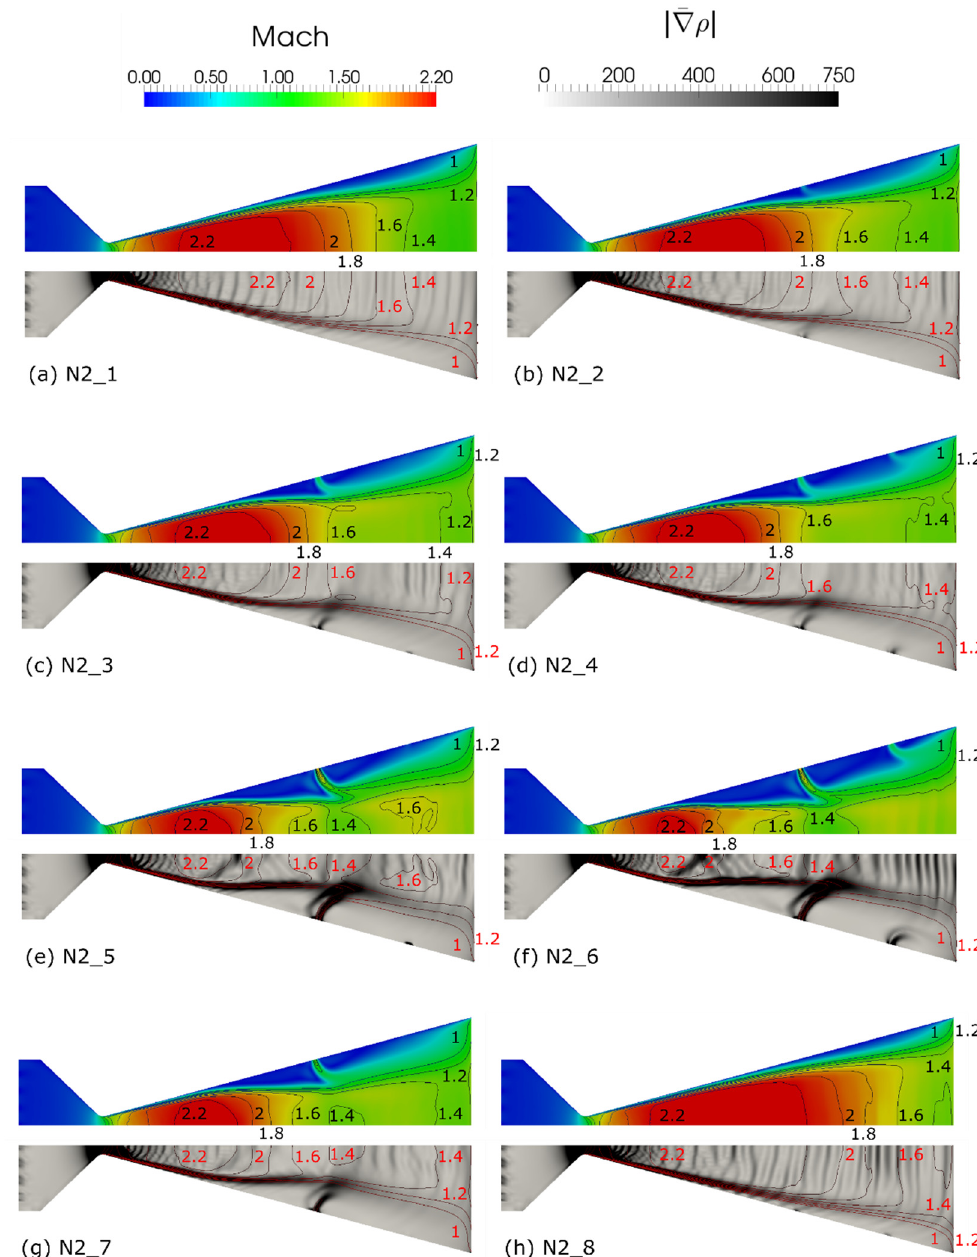
Figure 9. Contour plot of the Mach number and Schlieren computations: ( a ) test case N2_1 (baseline); ( b ) test case N2_2 (additional mass flow rate, jet 1 = ON, jet 2 = OFF); ( c ) test case N2_3 (additional mass flow rate, jet 1 = ON, jet 2 = OFF); ( d ) test case N2_4 (additional mass flow rate, jet 1 = ON, jet 2 = ON); ( e ) test case N2_5 (additional mass flow rate, jet 1 = ON, jet 2 = OFF); ( f ) test case N2_6 (additional mass flow rate, jet 1 = ON, jet 2 = ON); ( g ) test case N2_7 (bypassed mass flow rate, jet 1 = ON, jet 2 = OFF): ( h ) test case N2_8 (additional mass flow rate, jet 1 = OFF, jet 2 = OFF).